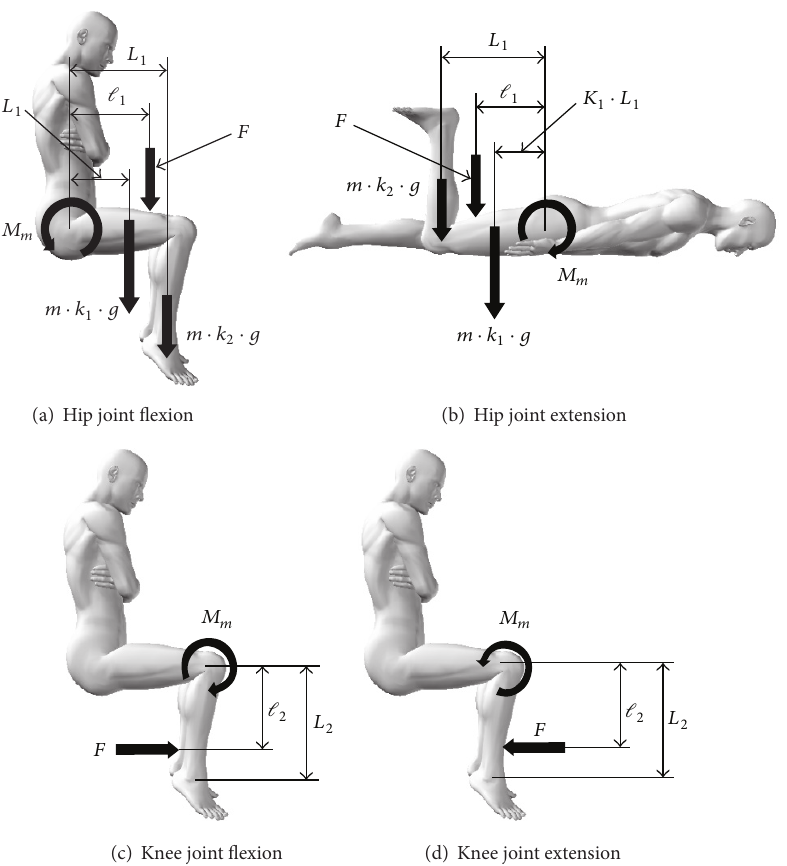
Figure 3: Calculating 𝑀 𝑚 . 𝑚 : body weight (kg), 𝑔 : acceleration due to gravity (m/s 2 ) = 9.8, 𝐿 1 : thigh length (m), 𝑘 1 : thigh weighting factor (men: 0.1; women: 0.1115), 𝐾 1 : thigh center of gravity distance ratio = 0.42, 𝑘 2 : lower leg and foot combined weighting factor (men: 0.0725; women: 0.0685), 𝐿 2 : lower leg length (m), ℓ 1 : distance (m) between the greater trochanter and the measurement site, and ℓ 2 : distance (m) between the knee joint space and the measurement